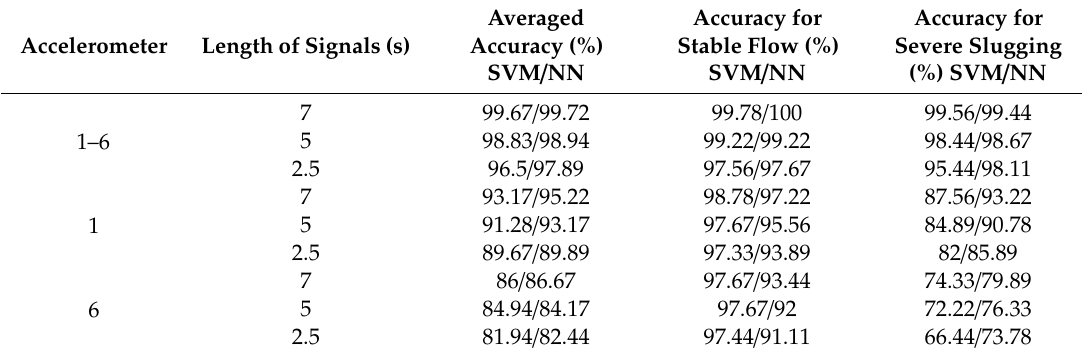
Table 3. Binary classification results of the SVM and NN.